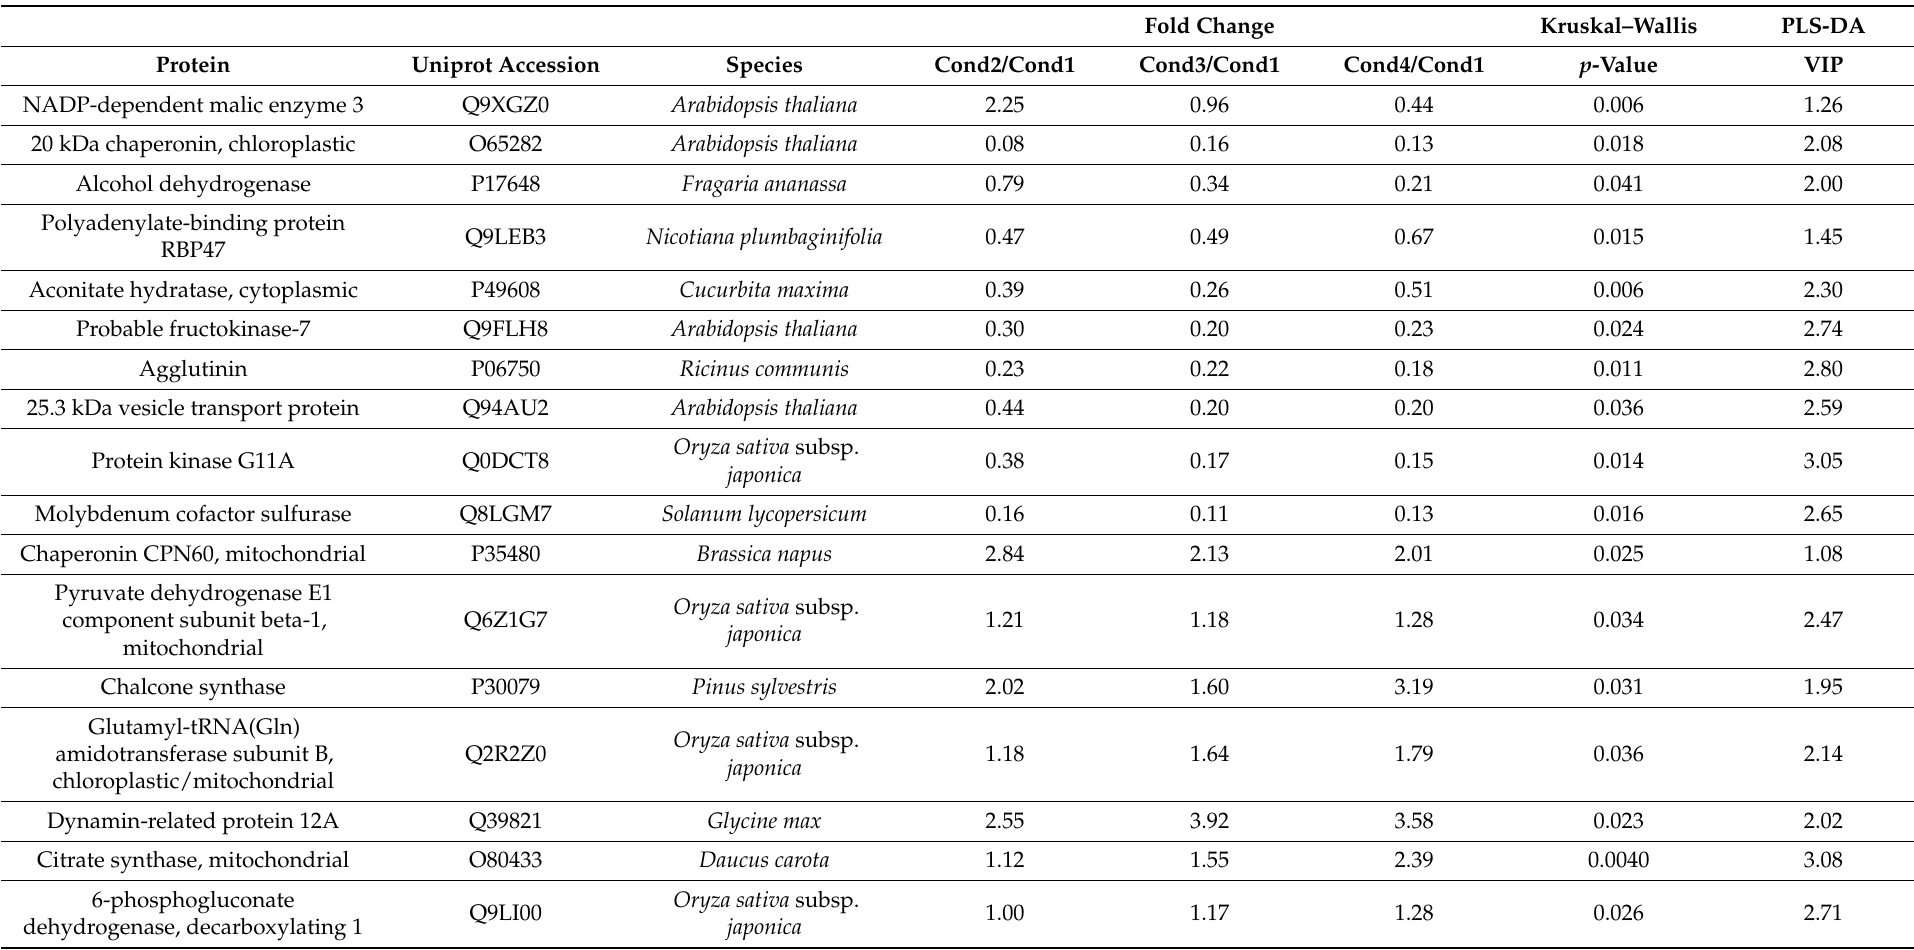
Table 1. Details of the twenty-seven proteins with higher interest, selected from the combination of the multivariate (PLS-DA) and the univariate statistical analysis (Kruskal–Wallis), detected in P. halepensis EMs induced under different temperature treatments: Cond1: 23 ◦ C; Cond2: 40 ◦ C (4 h); Cond3: 50 ◦ C (30 min); Cond4: 60 ◦ C 5